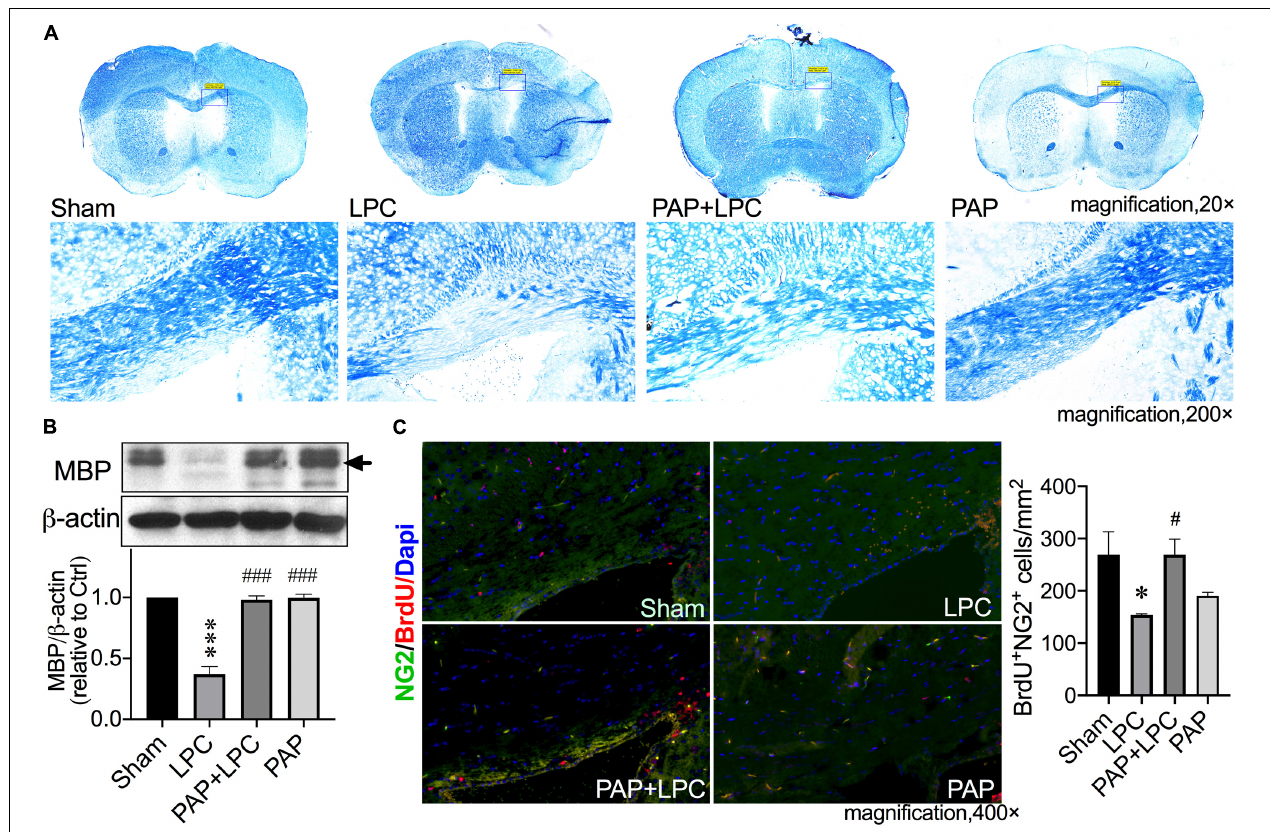
FIGURE 5 | Kv1.3 blockade protected corpus callosum from LPC-induced demyelination in vivo . The frozen sections were obtained from the demyelination model induced by stereotaxic injection of LPC (two points, 1%, 1 µ L of each point) in corpus callosum. Mice were treated with or without PAP (6 mg/kg) and accepted BrdU (50 mg/kg) by i.p. injection. (A) Representative images of myelin sheath LFB staining (blue) in coronal sections of animal brain tissues. The low-magnification views (first line) show the complete coronal section, in which the framed parts are enlarged into the high-magnification views showing below. Compared with sham group, the injection site of LPC reduced significantly in overall density of staining for myelin. PAP significantly improved the LPC-induced myelin damage. (B) Western blot analysis of MBP expression in brain tissues around the injected points dissected out from the brain. The band marked by the arrow is a protein band with a size of 18.5 kDa. Blockade of Kv1.3 significantly prevented corpus callosum from LPC-induced MBP reduction ( n = 3). (C) Representative images of merged BrdU immunofluorescence staining (red), NG2 (green), and DAPI (blue) in sections. There were 10 randomly selected visual fields counted for each experimental group from three independent treatments. Cell density of BrdU + NG2 + cells are shown in the bar graph (right). The LPC-induced decrease in BrdU + NG2 + cells density was mitigated by PAP. ∗ P < 0.05 vs. sham, ∗∗∗ P < 0.001 vs. sham. # P < 0.05 vs. LPC, ### P < 0.001 vs.